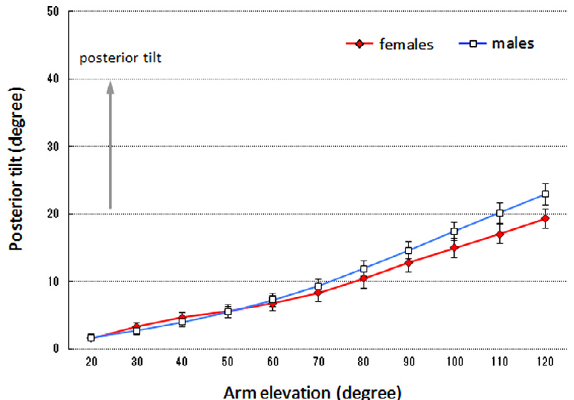
Figure 3. Mean scapular posterior tilt. The error bars represent the standard error of the mean. There was no significant difference between the sexes ( p = 0.43).